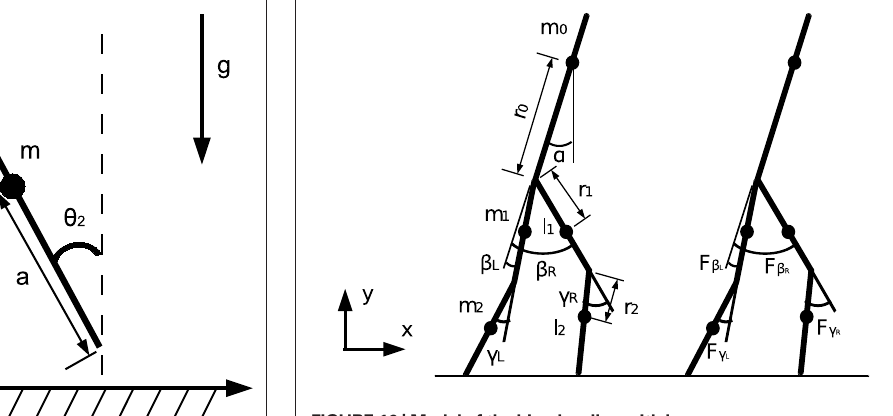
FIGURE 16 | Model of the biped walker with